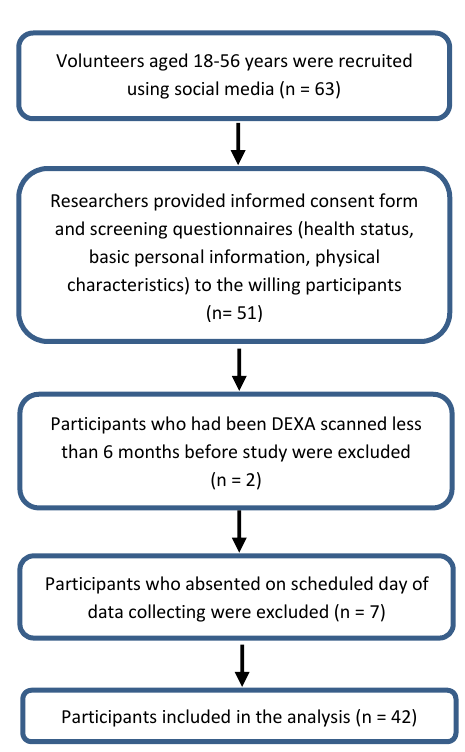
Fig.1: Flow chart of the study participants included in the